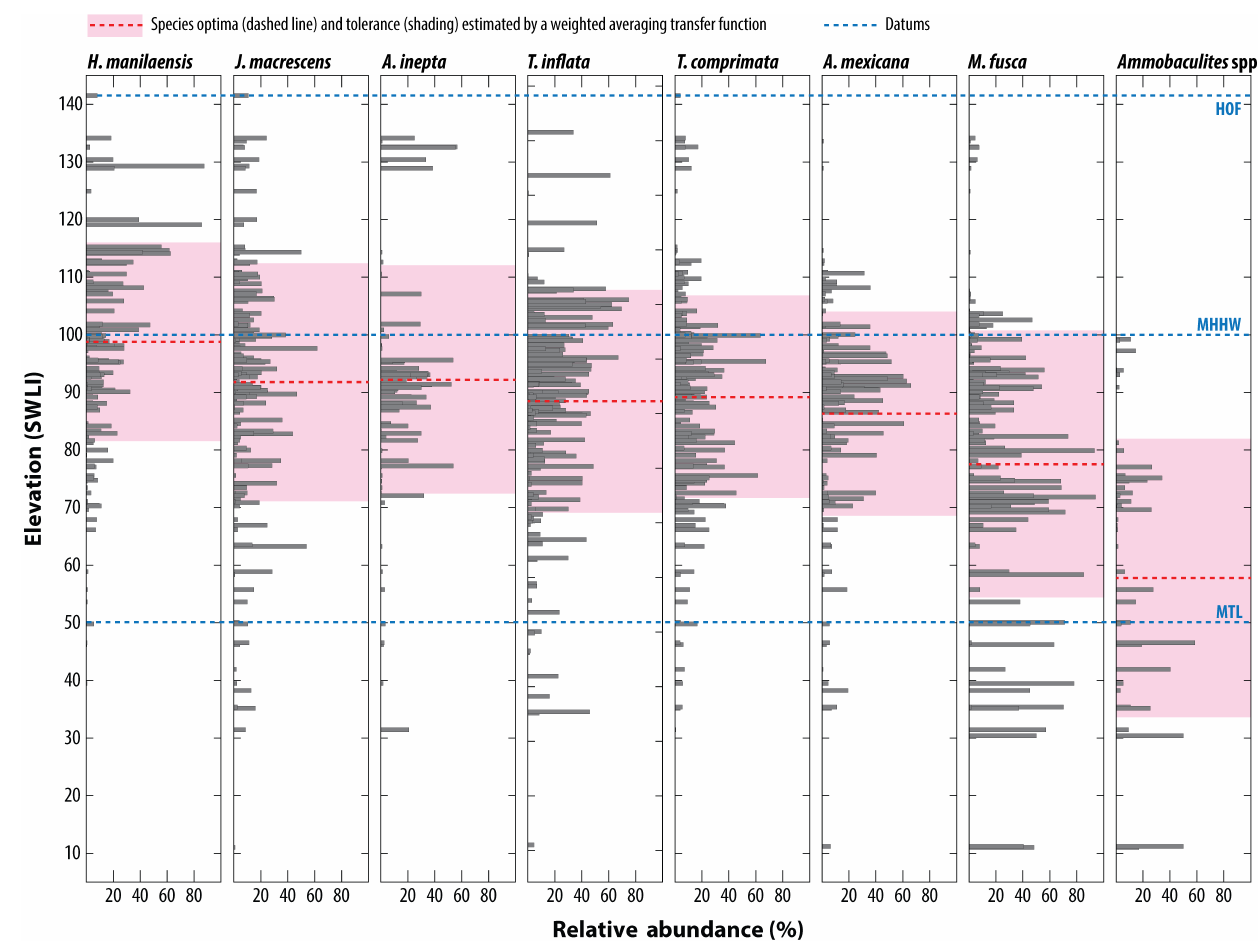
Figure 2. Data set of modern foraminifera described from a total of 172 surface sediment samples from 12 different sites. The data are presented as relative abundances. Only the abundance of the eight most common species are shown. Modified from Kemp et al. (2013a). Red dashed lines and pink shading indicate the species optima and tolerances estimated by the weighted averaging transfer function. Tidal datums are indicated by blue dashed lines. HOF is highest occurrence of foraminifera, MHHW the mean higher high water, and MTL the mean tide